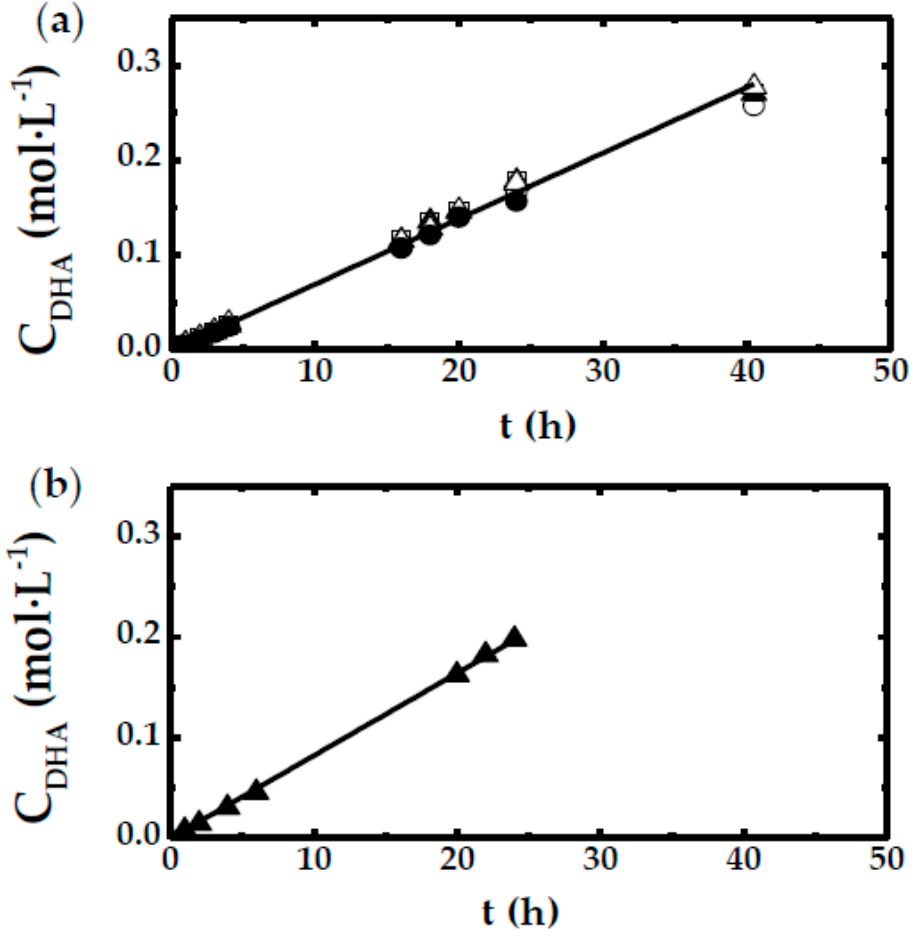
Figure 7. Reproduction of DHA concentration vs. time for ( a ) runs 1 to 6 (carried out in shake flasks) and ( b ) for run 19 (carried out in STBR), the agitation being ( a ) 100 rpm (flasks) and ( b ) 300 rpm (STBR). Di ff erent biomass concentrations were employed according to the following legends: 0.1 ( (cid:8) ), 0.2 ( ), 0.3 ( (cid:4) ), 0.4 ( (cid:3) ), 0.5 ( (cid:78) ), and 1.0 g · L − 1 ( ∆ ). Points corresponding to experimental results, lines (cid:35) corresponding to kinetic model simulation when the oxygen transport rate (OTR) is controlling the overall process rate. Model Equations (2) and